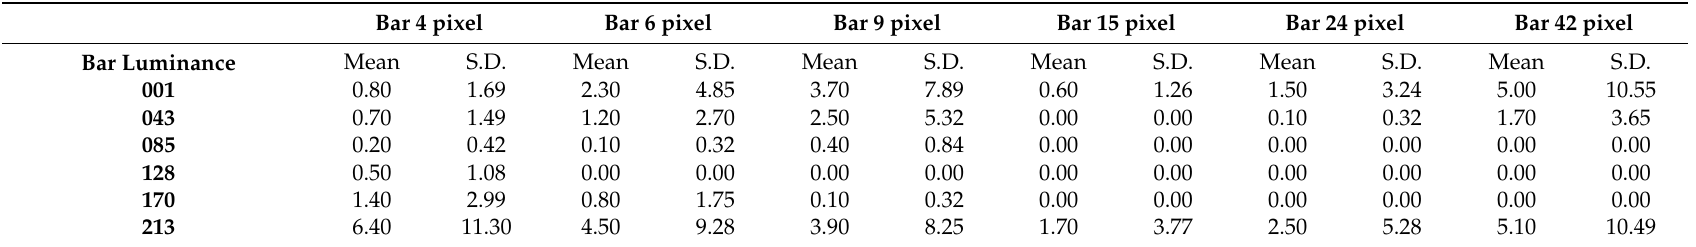
Table 3. Results of the first group of tests: uniform Bar on uniform Background, Bar Luminance manipulation.